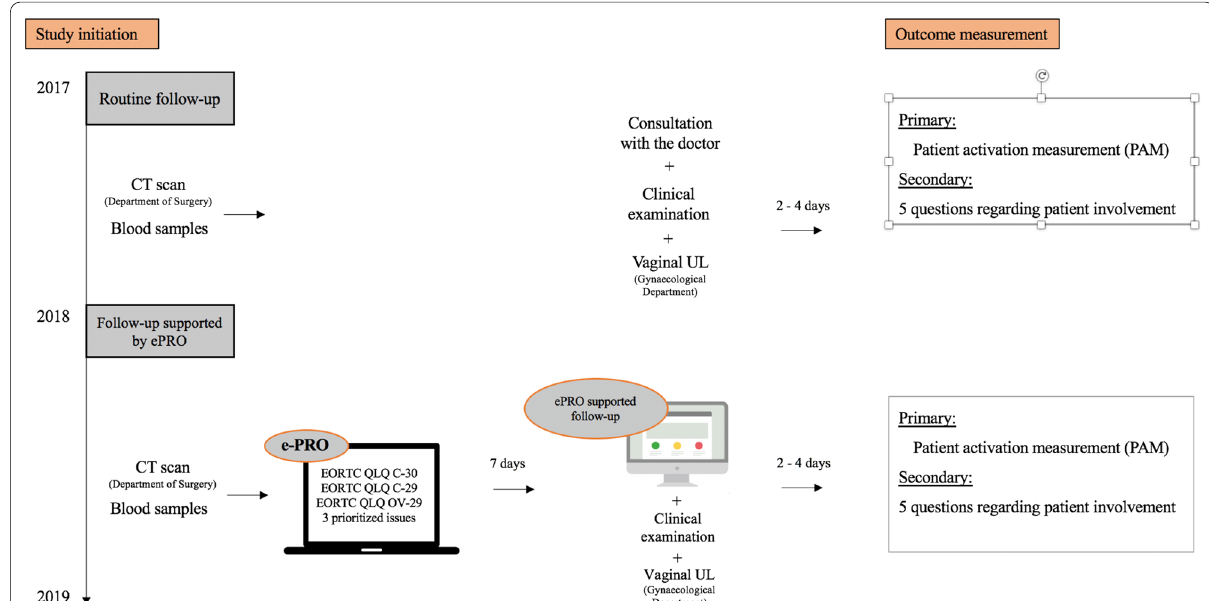
Fig. 1 The setting. ePRO: electronic patient-reported outcomes, EORTC: European Organisation for Research and Treatment of